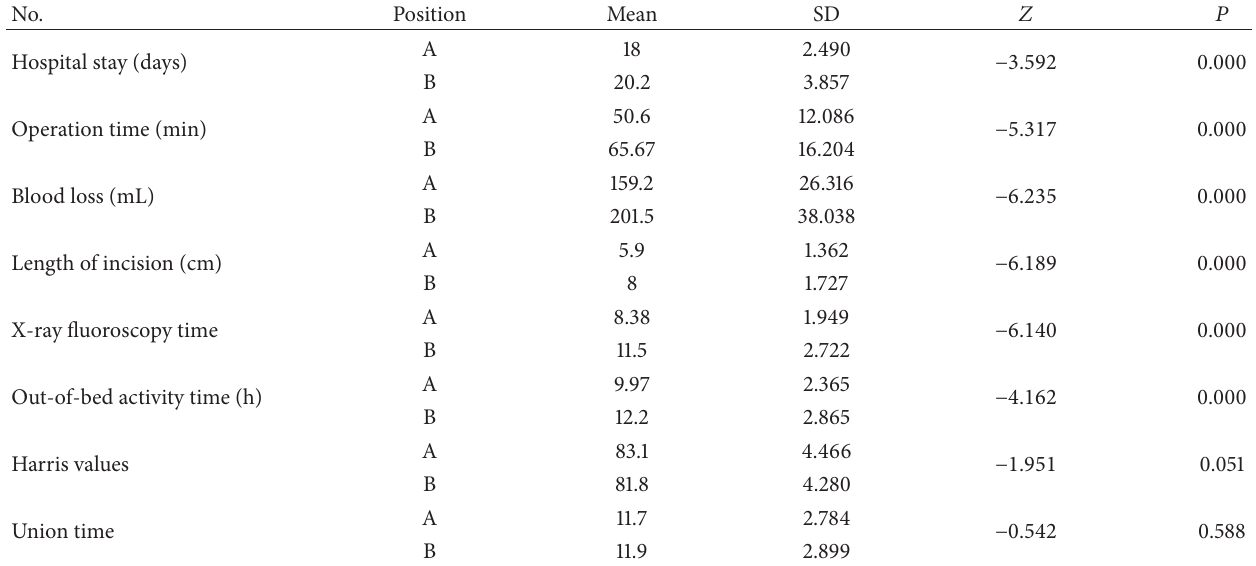
Table 2: Comparison of scores in the lateral decubitus position and supine position groups after treatments.